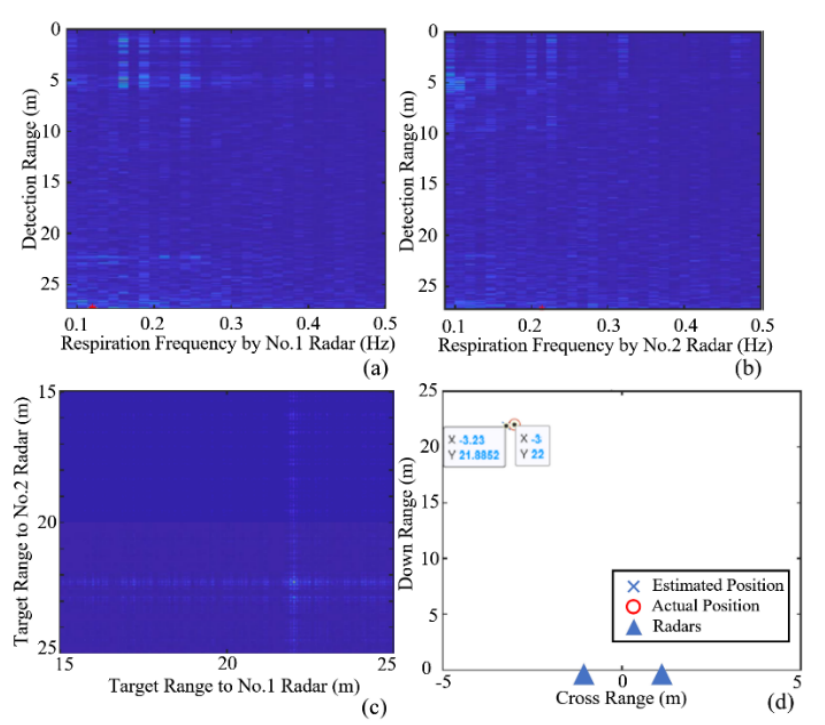
Figure 14. The experiment B result. ( a , b ) The output range-frequency images using the normal FFT-based respiration detection methods using the echoes from a single radar. ( c ) The output two-dimensional (2D) slice (range × range) image for the specific respiration frequency. ( d ) The positioning result calculated by the radar system is compared with the actual position of the person. between people and radars is 13.14 ◦